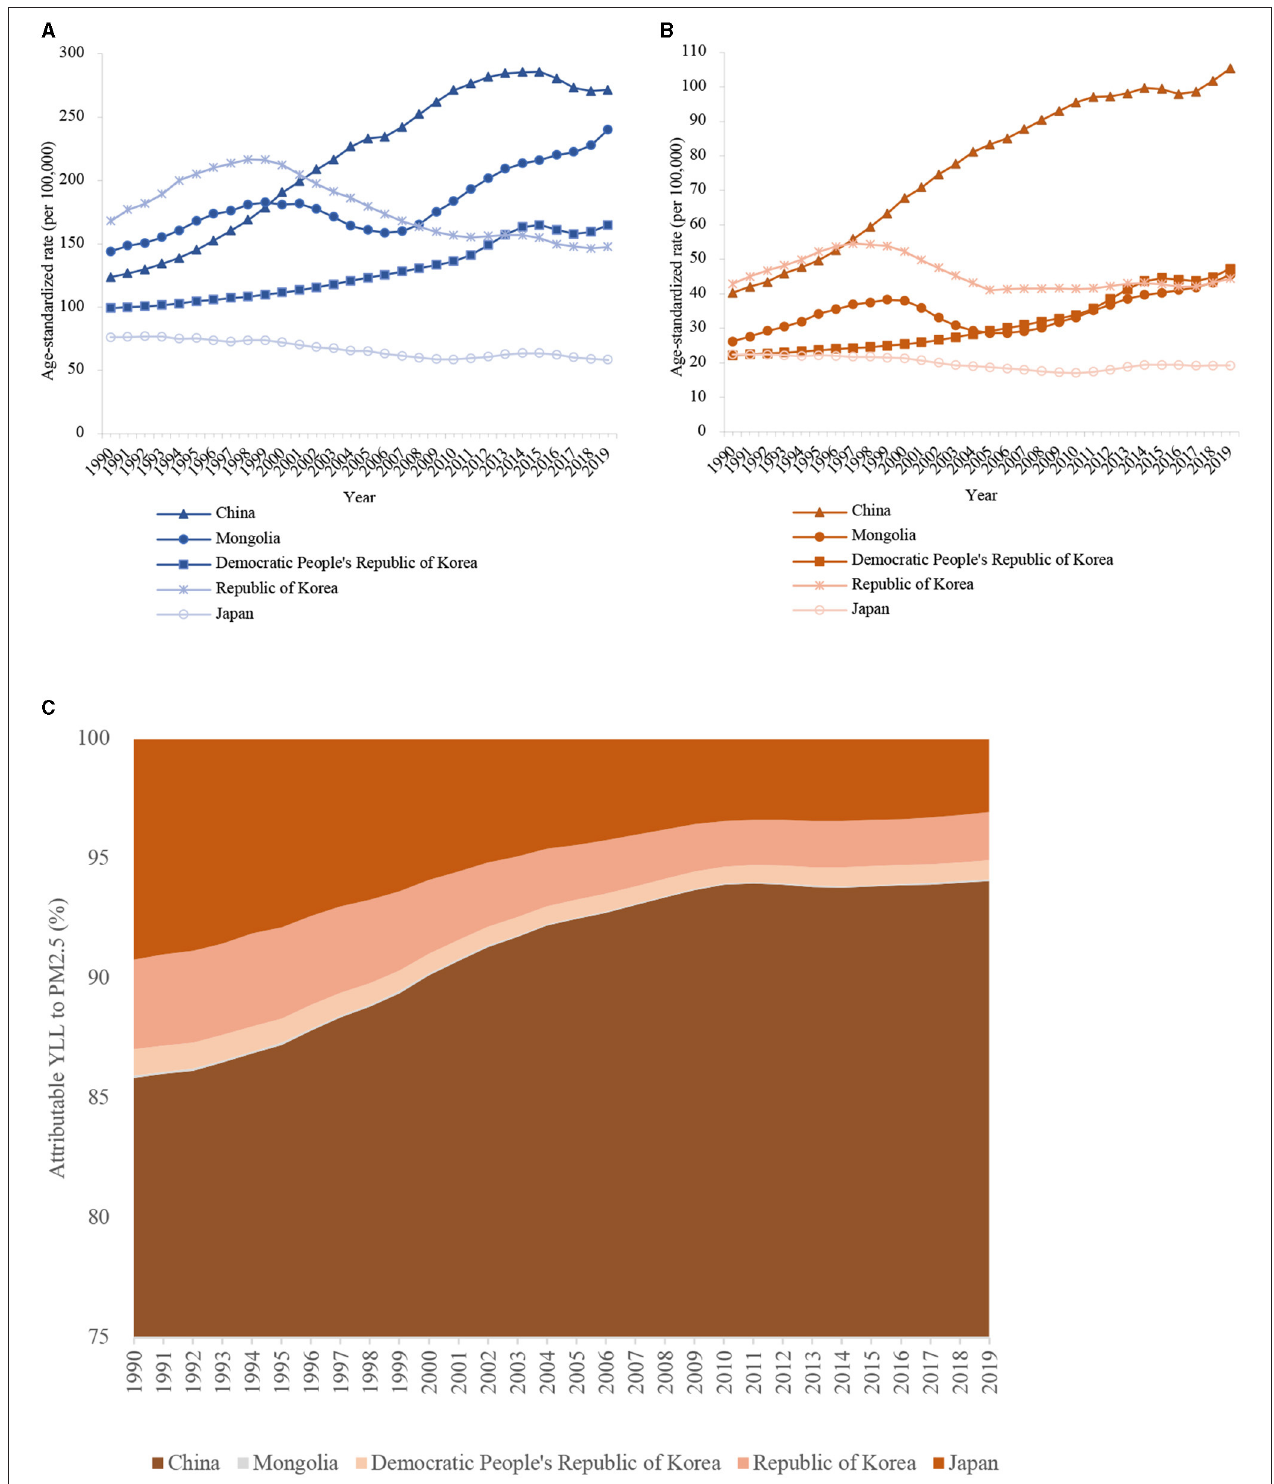
FIGURE 3 | The age-standardized rates of lung cancer attributable YLL to PM 2.5 in East Asia for both sexes at all ages, during 1990–2019. (A) male patients; (B) female patients; (C) The proportion of lung cancer YLL attributed to ambient PM 2.5 in East Asia countries from 1990 to 2019.